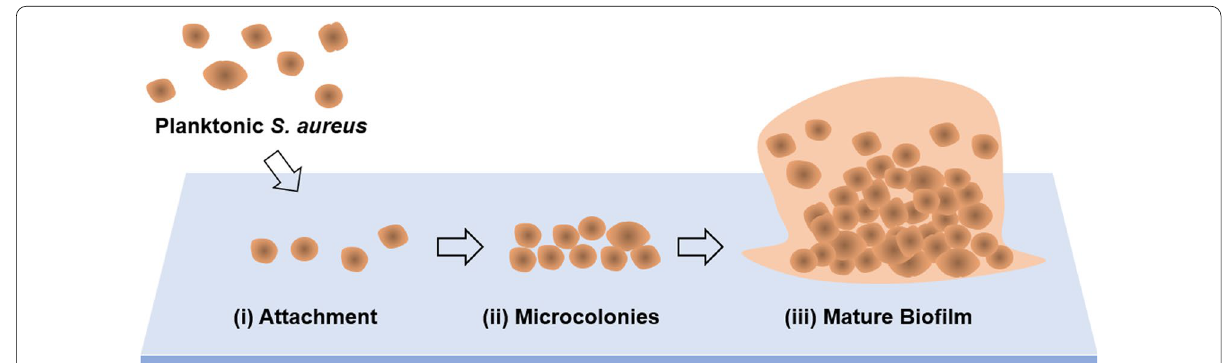
Fig. 1 Model of S. aureus biofilm development: (1) During the attachment phase, planktonic S. aureus adheres to a biotic surface and forms a monolayer. (2) After the attachment is accomplished, microcolonies are formed with multilayering cells. (3) The microcolonies evolve into a